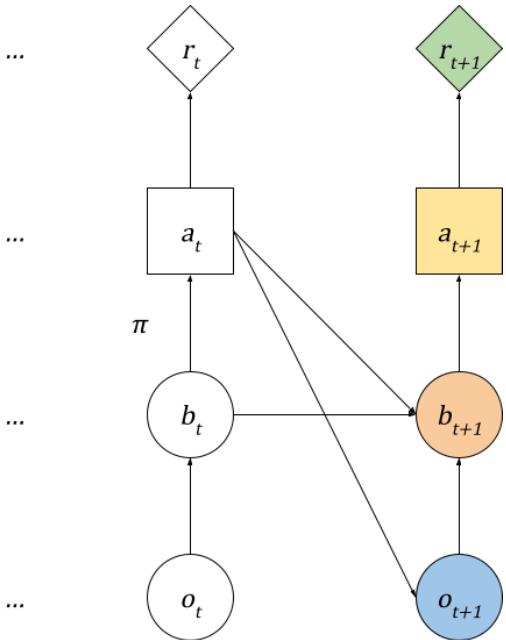
Figure 4. Exploration Markov decision process. At each decision step, the agent selects an action a t based on its current belief regard- ing the world state using a planner (π) . The agent takes the action in the world and observes some new data o t + 1 . These data are used to update the belief b t + 1 for the next step. Each action results in a reward.